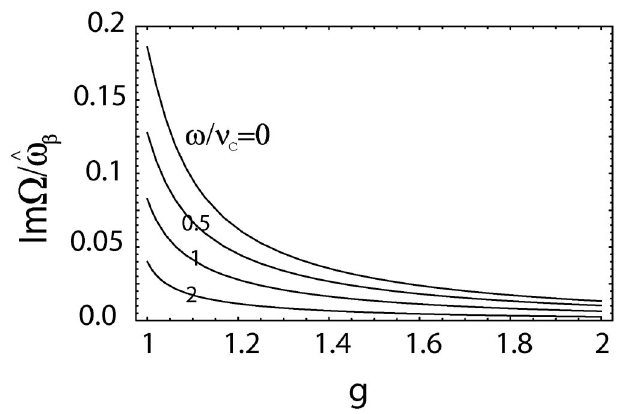
FIG. 7. Plots of the normalized growth rate Im(cid:30) =! the geometrical factor g obtained from Eq. (16) for several values of the frequency ratio !=0 (cid:7) 0 f m